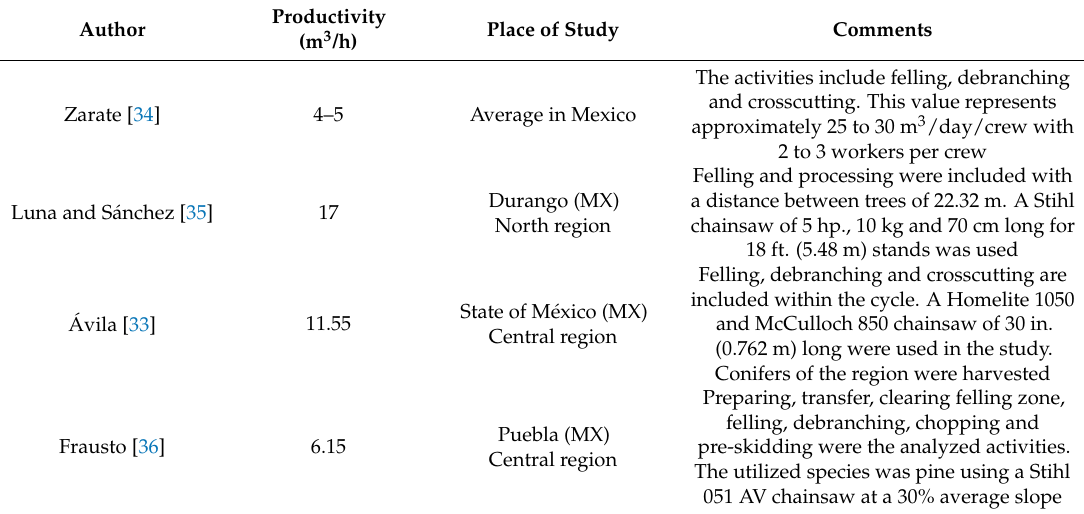
Table 13. List of productivities of manual felling based on time studies in